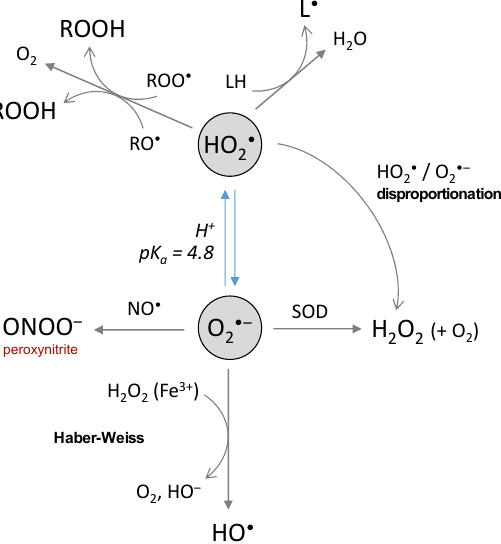
Figure 2. The chemical reactions of the superoxide and the perhydroxyl radicals.